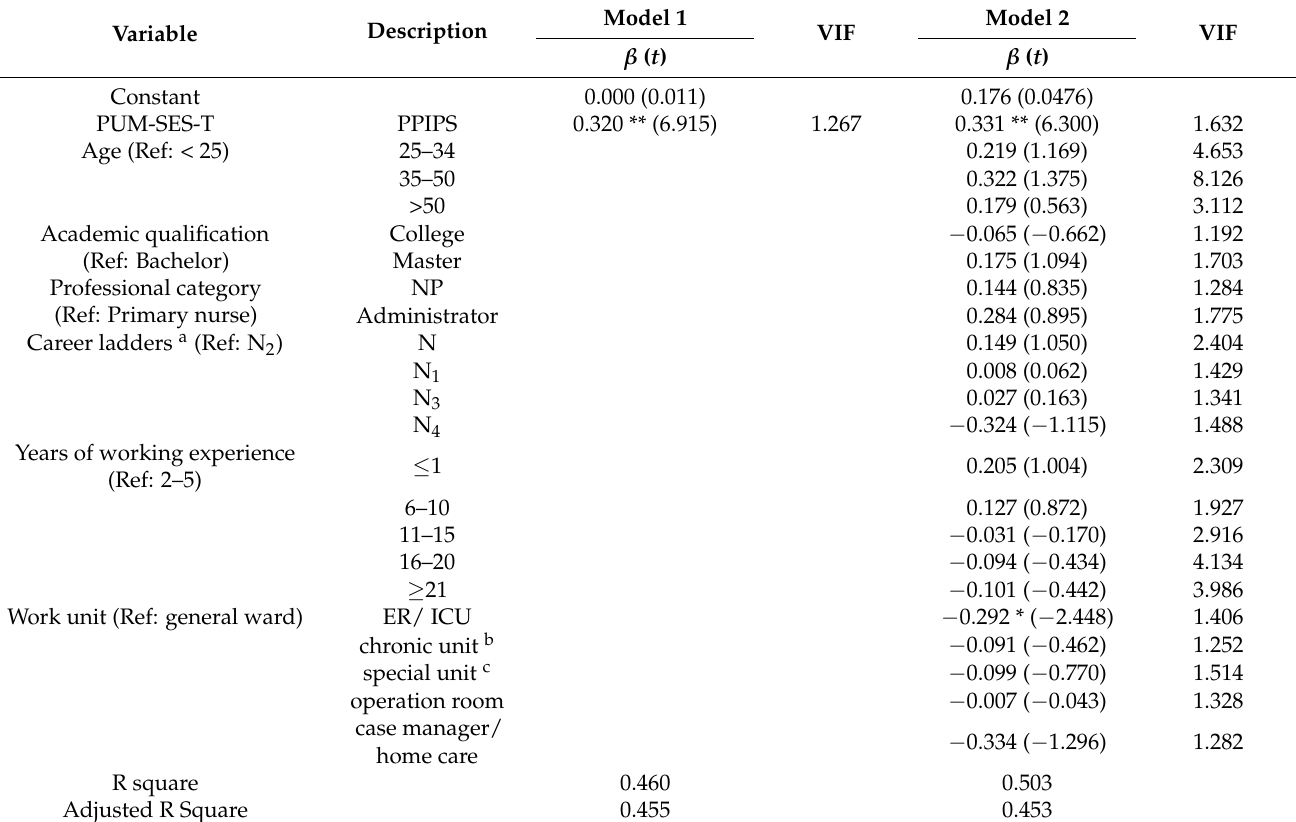
Table 3. The predicting outcome of PUM-SES-T on